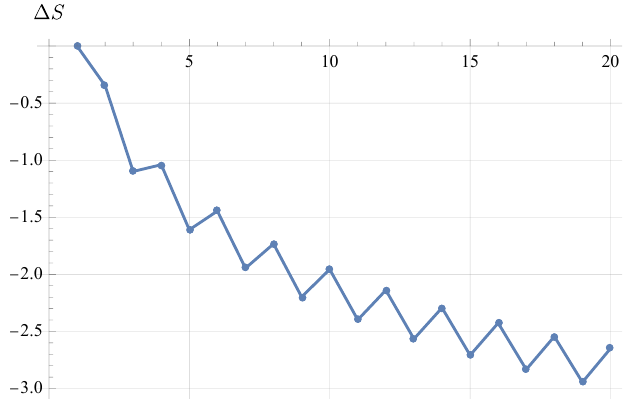
Figure 20 . The difference ∆ S of the pseudo entropy from the average of the entanglement entropies varying the level k . We set ‘ 12 = 2 , ‘ 0